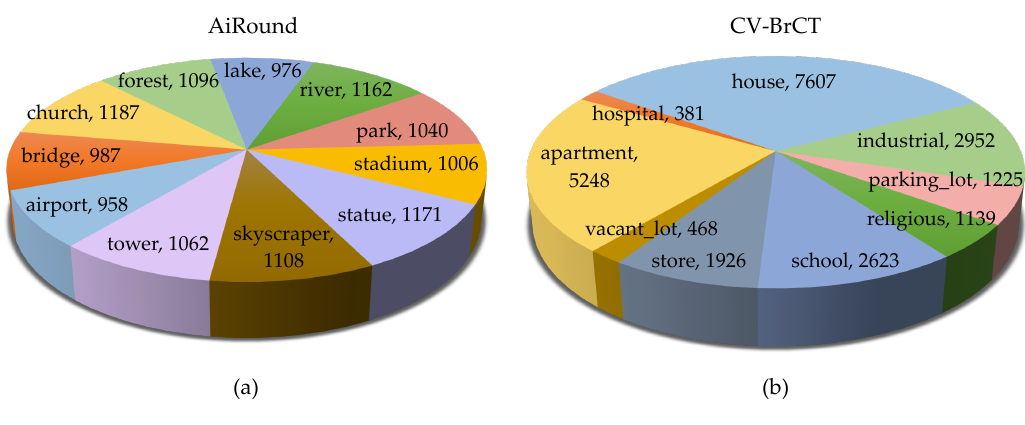
Figure 2. Class distribution of the ( a ) AiRound and ( b ) CV-BrCT dataset. The CV-BrCT dataset contains 23,569 pairs of images in 9 classes: apartment, hospital, house, industrial, parking lot, religious, school, store, and vacant lot. Each pairs are com- posed of an aerial view image and a ground view image, both of which are 500 × 500 RGB images. The class distribution is shown in Figure